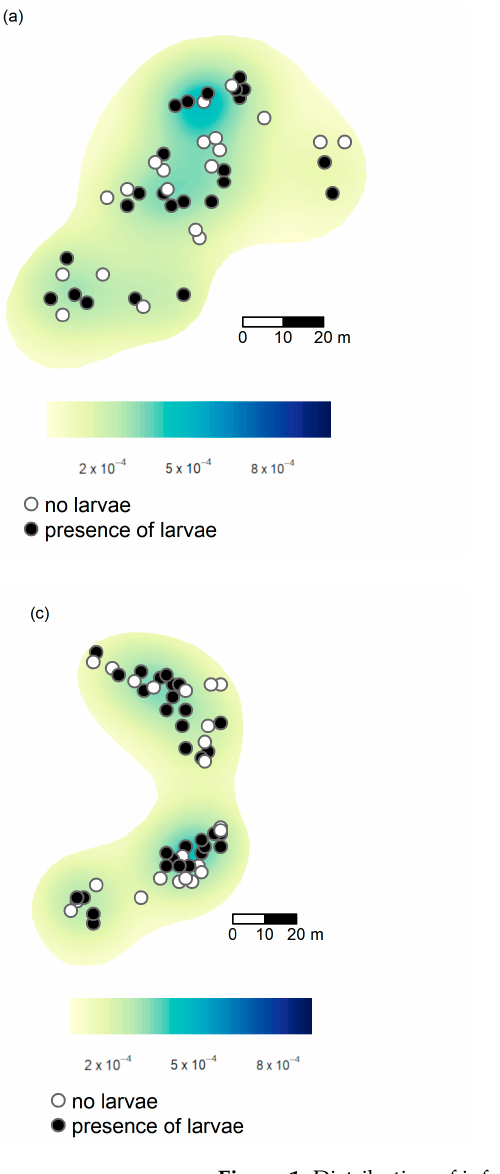
Figure 1. Distribution of infested (black dots) and non-infested (white dots) Myrmica nests in Krak ó w during ( a ) autumn and ( b ) late spring and in Kosy´n during ( c ) autumn and ( d ) late spring. The Kernel-smoothed probability density of larvae is shown in the background (colour shades). Table 1. Information on Myrmica host colonies and their social parasites in two sampled populations. Symbols: T— Maculinea teleius , N— Maculinea nausithous , A— Maculinea alcon , M— Microdon myrmicae . Some nests with double infestation were also